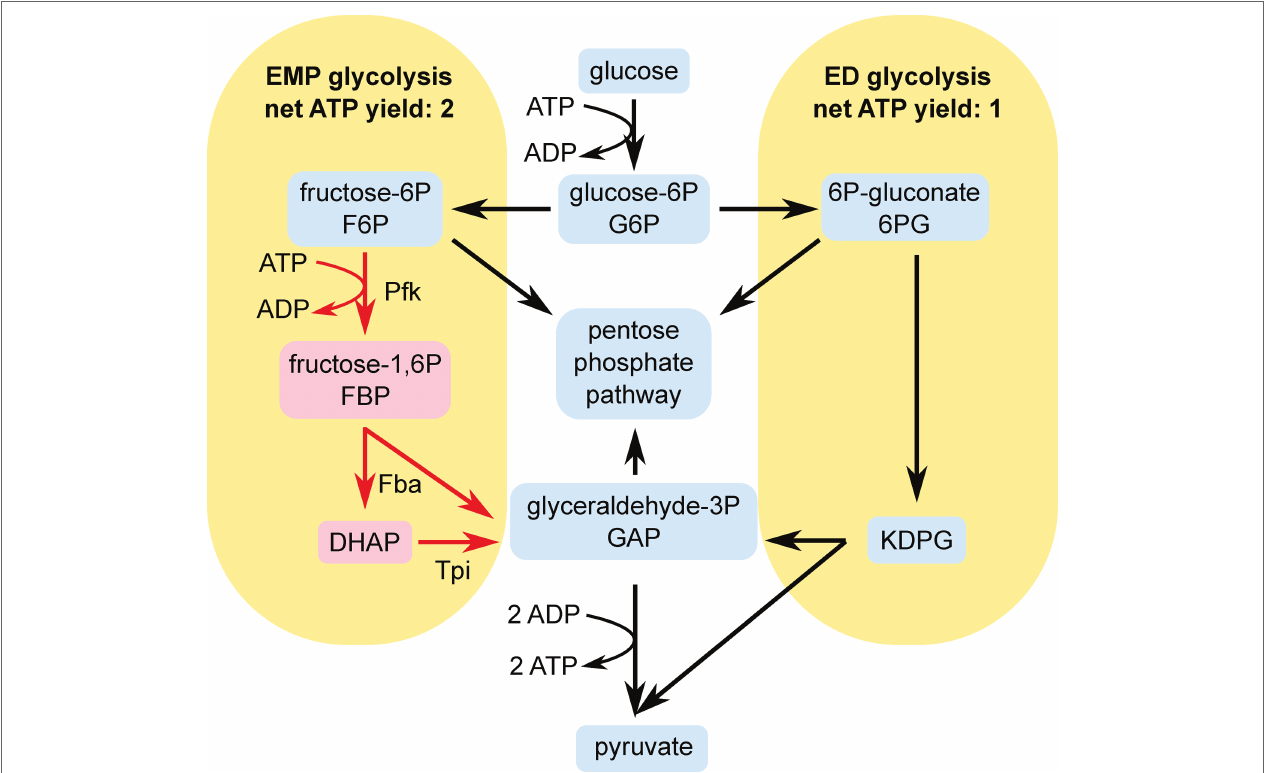
FIGURE 1 | Simplified schematic of the EMP (left) and ED (right) pathways of glycolysis. Pfk, Fba, and Tpi reactions are indicated in red because heterologous expression of these enzymes was the major genetic change made in this study. Abbreviations: DHAP, dihydroxyacetone phosphate; KDPG, 2-keto-3-deoxy-6- phosphogluconate; Pfk, phosphofructokinase; Fba, fructose bisphosphate aldolase; Tpi, triosephosphate isomerase. The arrows show the directions of the flux through EMP or ED pathways and do not reflect reversibility/irreversibility of the